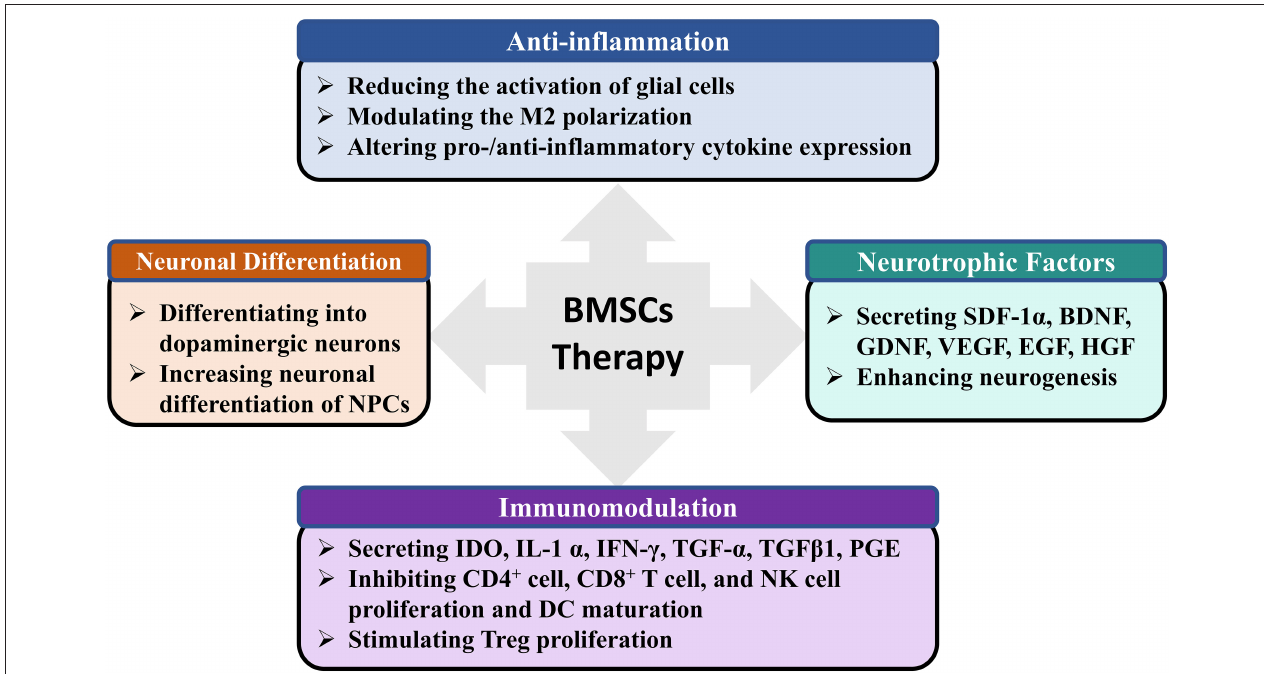
FIGURE 5 | The possible mechanisms of BMSCs therapy for PD. PD, Parkinson’s Disease; BMSCs, Bone marrow stromal cells; GDNF, SDF-1 α , Stromal cell-derived factor 1a; BDNF, Brain-derived neurotrophic factor; Glial cell-derived neurotrophic factor; VEGF, Vascular endothelial growth factor; EGF, Epidermal growth factor; HGF, Hepatocyte growth factor; NPCs, Neural progenitor cells; IDO, Indoleamine-2,3-dioxygenase; IFN γ , Interferon γ ; TGF- α , Transforming growth factor alpha; TGF β 1, Transforming growth factor beta 1; PGE, Prostaglandin; DC, Dendritic